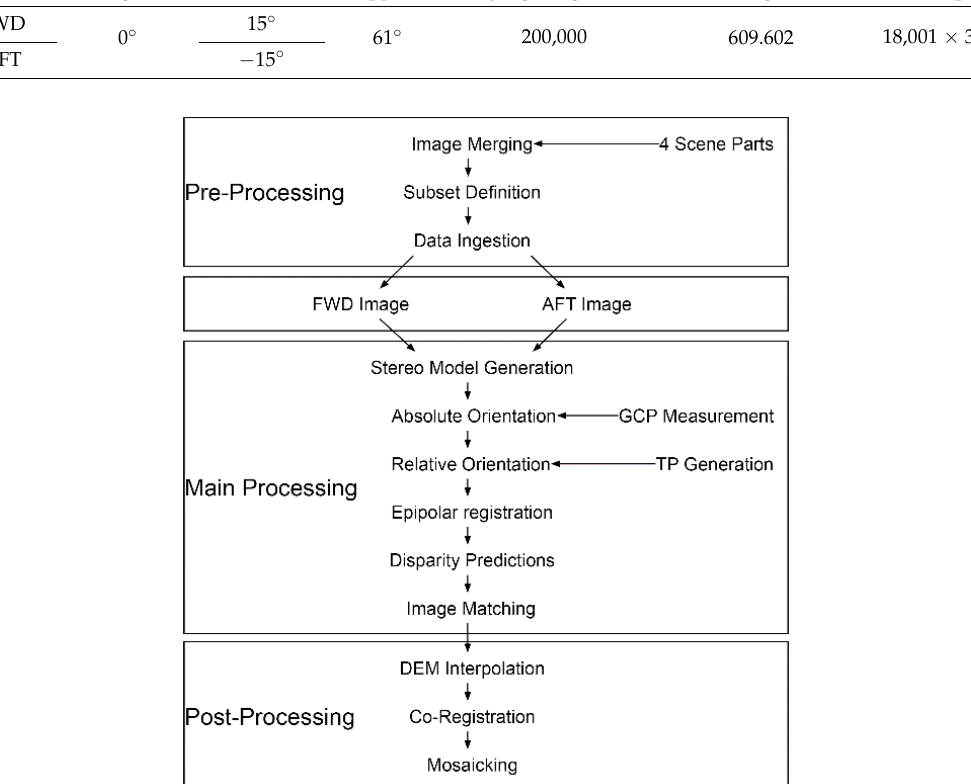
Figure 4. Corona DTM generation workflow. FWD, forward image; AFT, backward image.